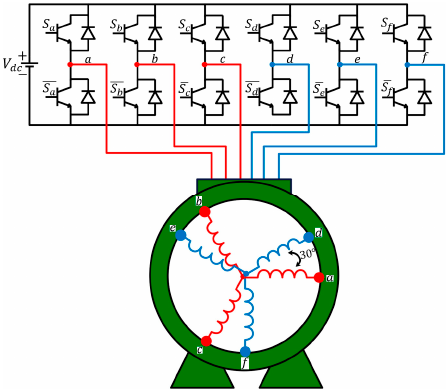
Figure 1. Asymmetrical six-phase IM fed by a six-phase 2L-VSI.